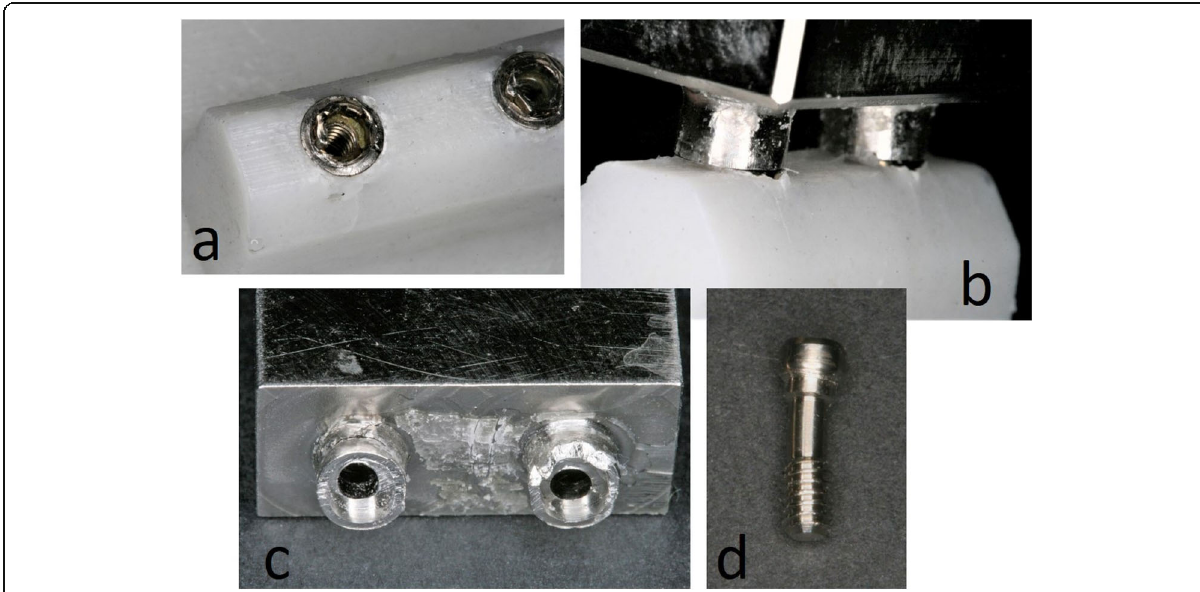
Fig. 5 Damage in the experimental model: a Fractures verified in the vestibular face of the implants ’ hexagons, as predicted after resign failure (compare with Fig. 4a). b Damage in the resin that simulates the bone tissue. Comparing with b , it is possible to visualize that similar zones are affected. c Damage observed in the prosthetic framework connector, in accordance with the simulation results (compare with c ). d Slight screw deformation found after the finished SCLT, similar to the results presented in d